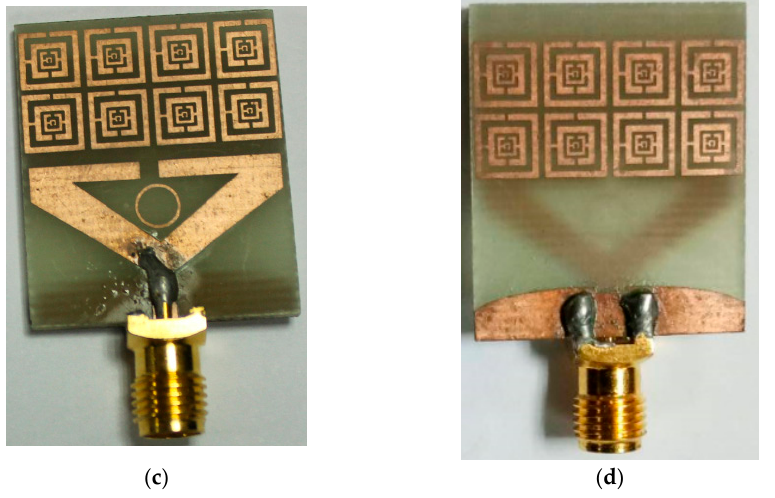
Figure 7. Geometric layout of proposed antenna ( a ) Front side ( b ) Back side ( c ) Fabricated prototype front side ( d ) Fabricated prototype back side. Table 3. Design specifications of MTM ‐ based ultra wideband (UWB) antenna (according to Figure 7).